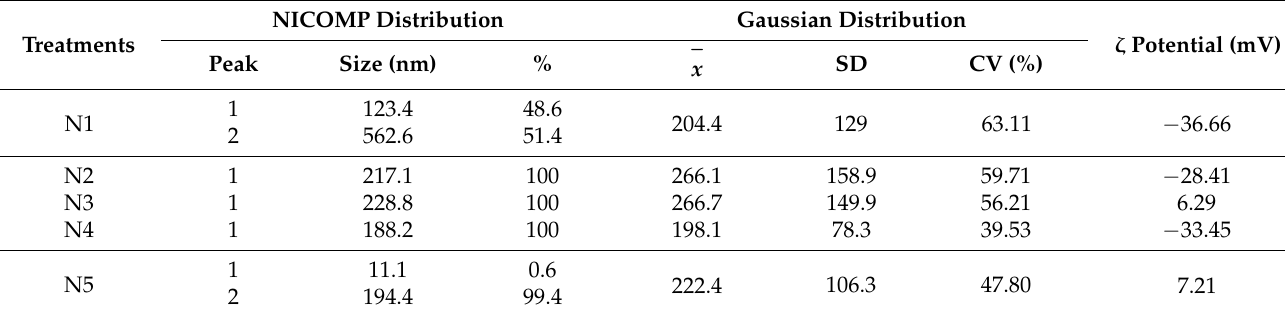
Table 4. Particle size and ζ